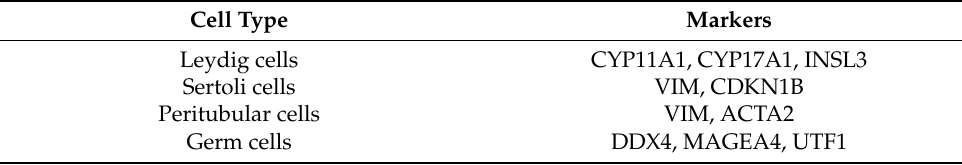
Table 1. Overview of identified markers for different testicular cell types.